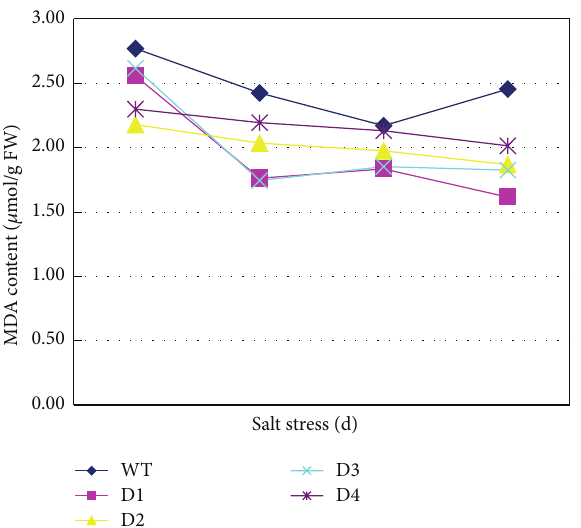
Figure 3: MDA content in the WT plants and SbPIP1 gene transgenic lines. D1, D2, D3, and D4 represent the transgenic lines D1, D2, D3, and D4, respectively; WT represents the untransformed wheat variety Ningmai 13.